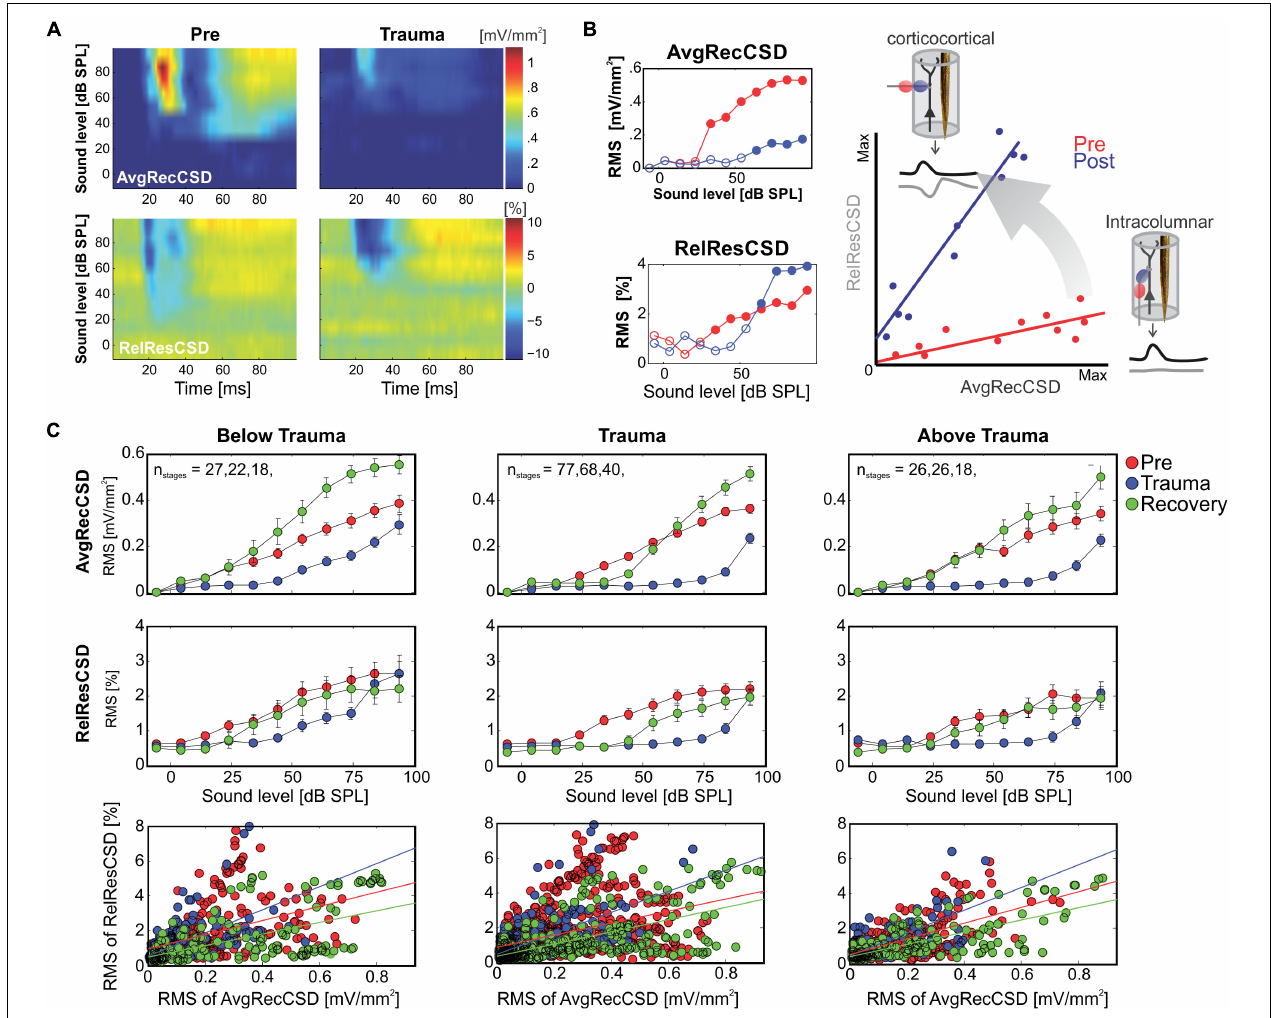
FIGURE 2 | (A) Representative example of AvgRecCSD (top panels) and RelResCSD (bottom panels) evoked by 1 kHz stimulation prior to (left) and after trauma induction (right) at a cortical site with a BF of 5.6 kHz. (B) For further quantitative analysis root-mean-square values during 100 ms stimulus presentation were calculated for AvgRecCSD and RelResCSD. Prior to trauma induction (red circles) the threshold of activation was 34 dB SPL (filled circles) and increased to 64 dB SPL after trauma. Small columnar insets schematize the effects of the geometrical arrangement of projection systems into a cortical column on the AvgRecCSD, a measure of the overall activity in a cortical column, and the RelResCSD, a measure of the unbalanced activity by sinks and sources, distributed across the cylinder of integration reconstructed around the recording site. While AvgRecCSD values generally decreased after trauma, RelResCSD values even increased from around 2 to 4%. Note, that both before and after trauma induction AvgRecCSD and RelResCSD were highly correlated ( p < 2 × 10 − 5 ). In the schematic depiction of the comparison between both parameters ( right ), red and blue lines indicate linear regression lines before and after trauma, respectively. Comparisons of their slopes and offsets allow us to investigate the effect of sound-trauma on local and corticocortical synaptic circuits. (C) Across all experiments and independent of the frequency of pure tone stimulation relative to the trauma frequency AvgRecCSD (top panels) values increased with increasing sound levels (data are shown as mean ± SEM). As for the individual example in panels (A,B) , RelResCSD (middle panels) values also increased with increasing level. Expectedly, after trauma a reduction of AvgRecCSD values was observed. Interestingly, several weeks after trauma (green circles – Recovery), higher mean AvgRecCSD values than before trauma were observed. These changes seem not to be counterbalanced by relative increases in RelResCSD values. A regression analysis on the relationship between AvgRecCSD and RelResCSD revealed significant correlations in all cases analyzed ( p < 10 − 13 ). For further quantitative analysis see main